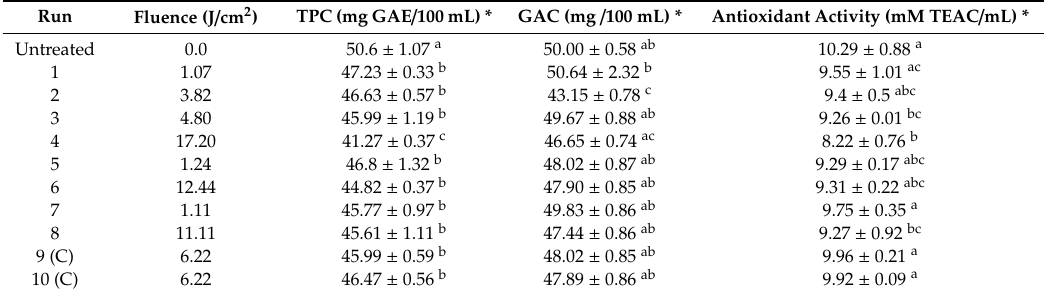
Table 2. Total phenolics content (TPC) and antioxidant activity measured by DPPH assay due to PL